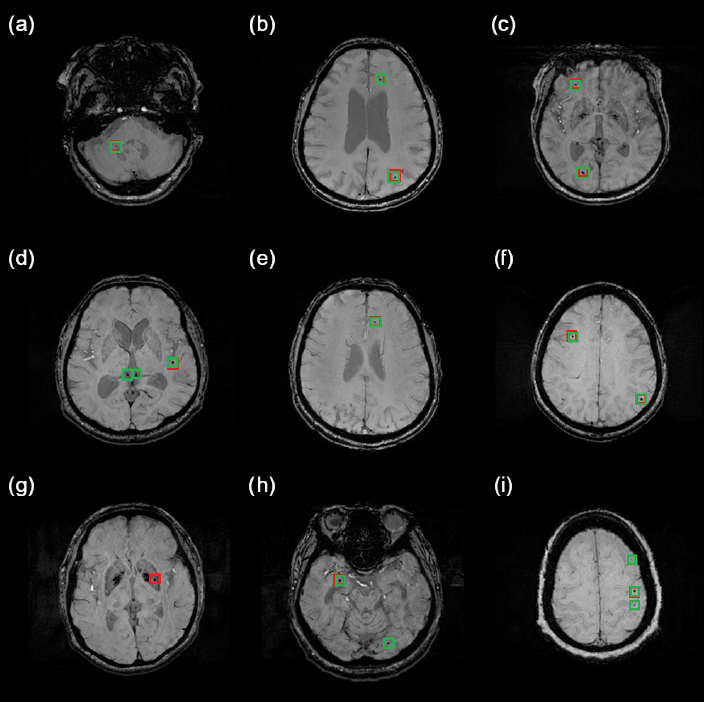
Figure 6. Samples of results obtained by the proposed system. With red box there are marked Ground truth CMBs are marked with red boxes, while predicted CMBs are marked green. Images were intentionally brightened just for presentation purposes. Examples ( a – c , e , f ) show correct